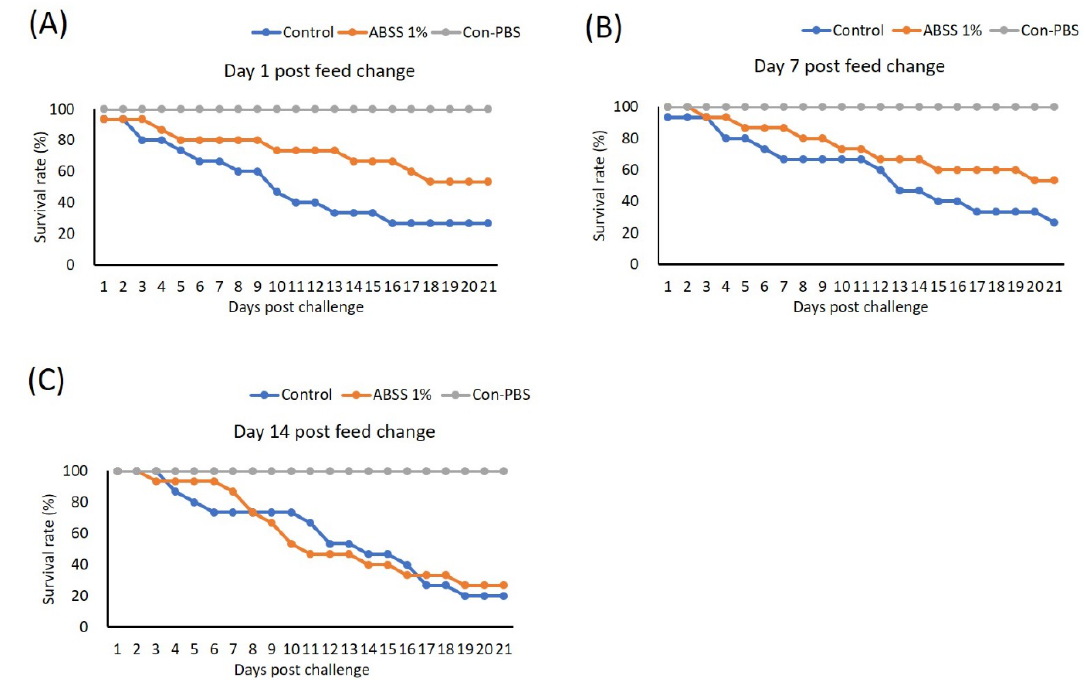
Figure 8. Fish were fed with feed containing 0 (control) and 1% Agaricus blazei spent substrate (ABSS) for 7 days, and the feed for the experimental group was then switched to the control feed and then fish were feed for ( A ) 1, ( B ) 7, and ( C ) 14 days prior to challenge with Streptococcus agalactiae . A control group that was injected with phosphate-buffered saline (PBS) was included (Con-PBS). Survival rates were recorded and calculated after 21 days of observation ( N = 10 per group).